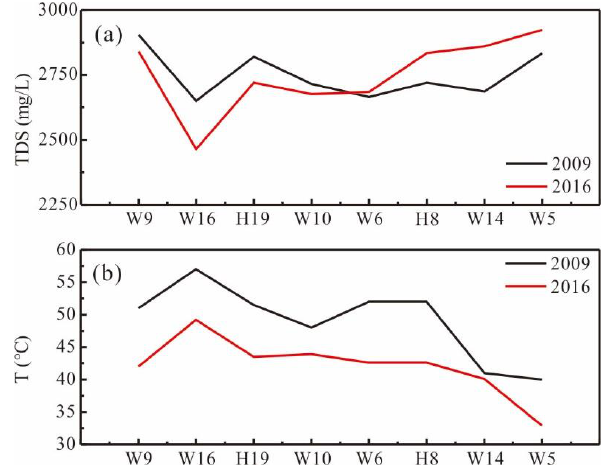
Figure 4. Changes in ( a ) Total Dissolved Solids (TDS) and ( b ) T in the water samples between 2009 and 2016.